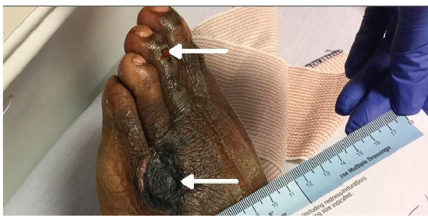
Figure 1: Ulcer on third and fifth toes (arrows).